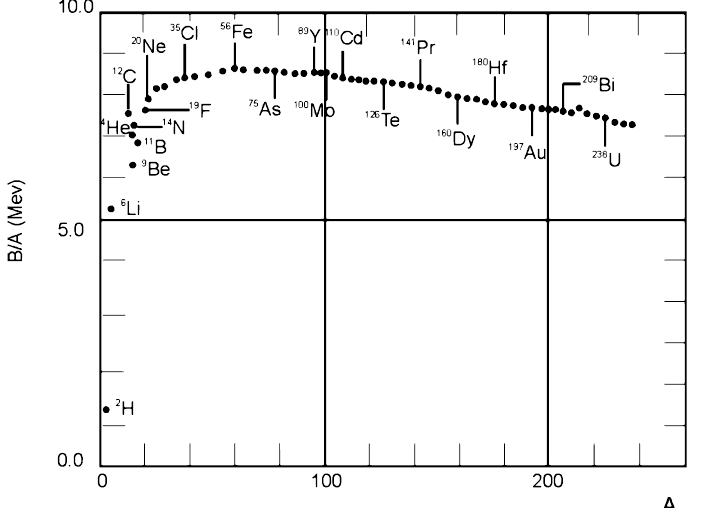
Figure 3. Binding energy per nucleon as a function of the number of nucleons. In this equation, from left to right, the quantities refer to a volume term, a surface term, a Coulomb term, an energy symmetry term and a pairing interaction term [14,15]. Of course, with so many parameters, other parameterisations can be obtained from the fitting of the data. One possible set is a v = 15.68 MeV, a s = 18.56 MeV, a c × e 2 = 0.72